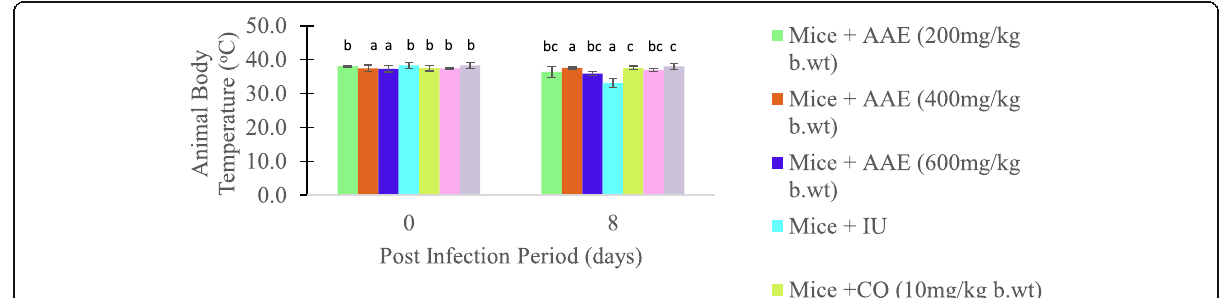
Fig. 4 Effect of aqueous extract of A. aspera shoot on the body temperature of mice infected with P. berghei (NK-65). Mice + AAE = infected mice treated with Achyranthes aspera aqueous extract, Con IU = infected mice untreated, Con CQ = infected mice treated with chloroquine (10 mg/